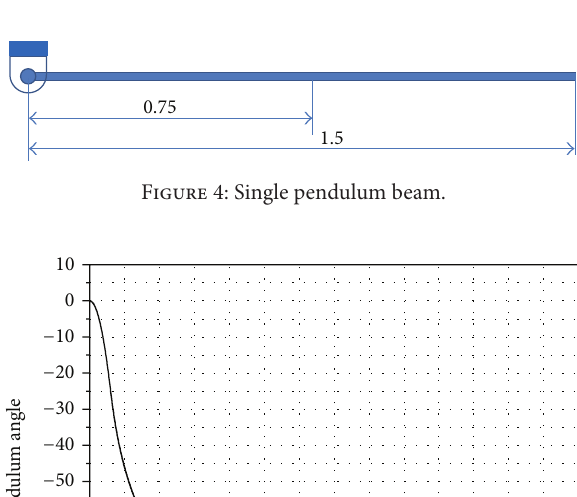
Figure 7: The potential energy of the pendulum.